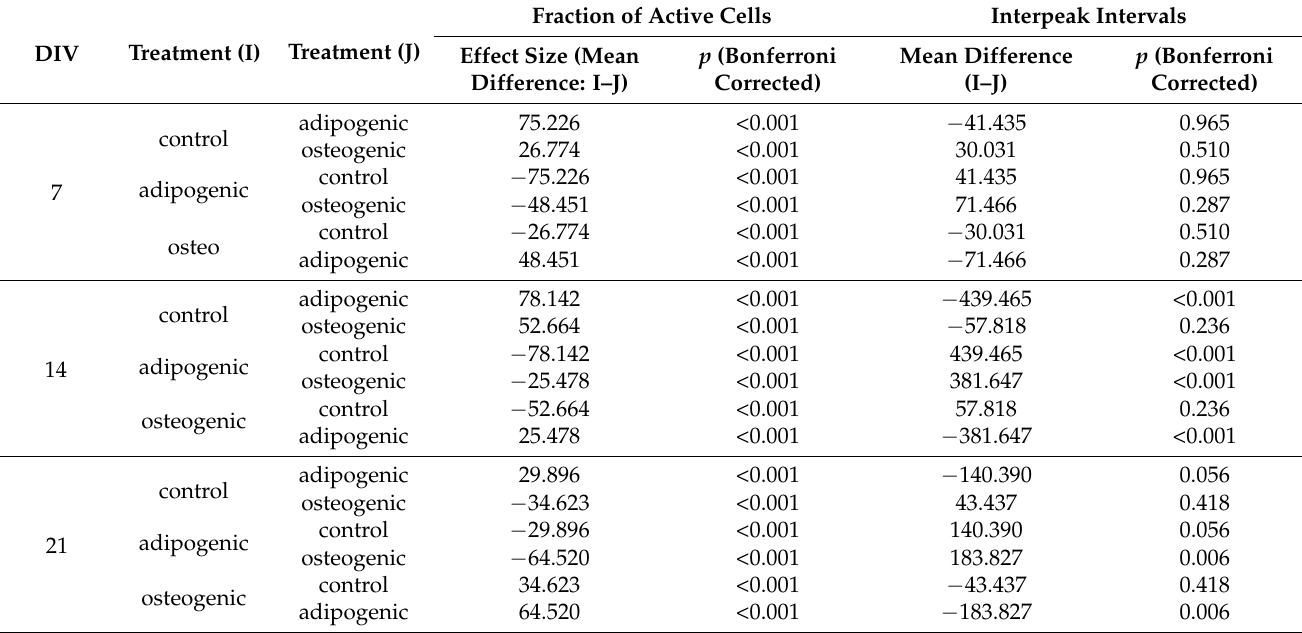
Table 2. Pairwise comparisons between treatments within each timepoint. p values have been calculated using unpaired Student’s t -tests with Bonferroni